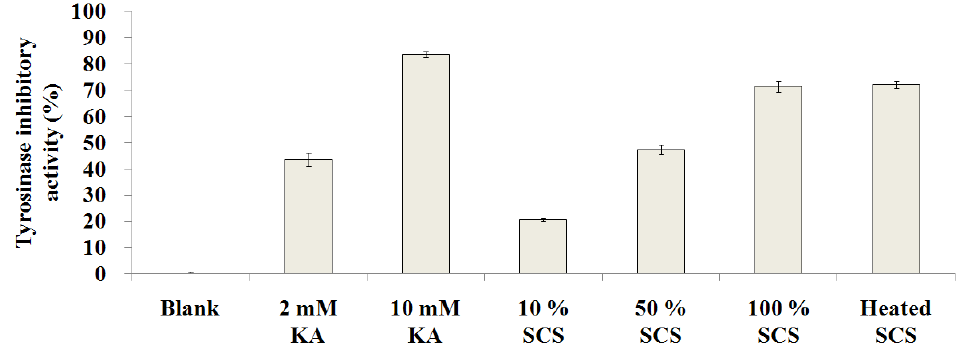
Figure 4. Tyrosinase inhibitory activities of standard samples and Lr-SCS